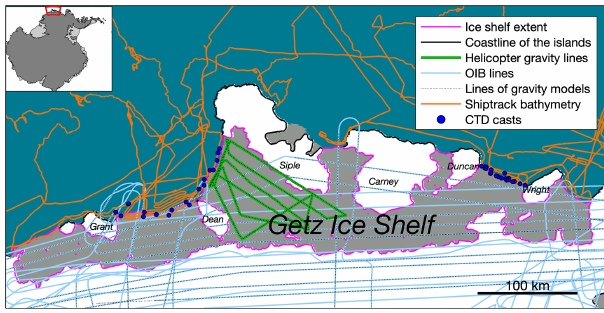
Figure 1. The geographic location and data coverage of Getz. The blue area is ocean. The gray area is Getz Ice Shelf. The white area is grounded ice. Colored lines and marks denote the ice shelf extent (Mouginot et al., 2017), helicopter gravity data, NASA OIB data (Cochran and Bell, 2010a), ship track bathymetry (Nitsche et al., 2007) and CTD casts (Locarnini et al., 2013). This plot is generated from the Antarctic Mapping Tool (Greene et al.,